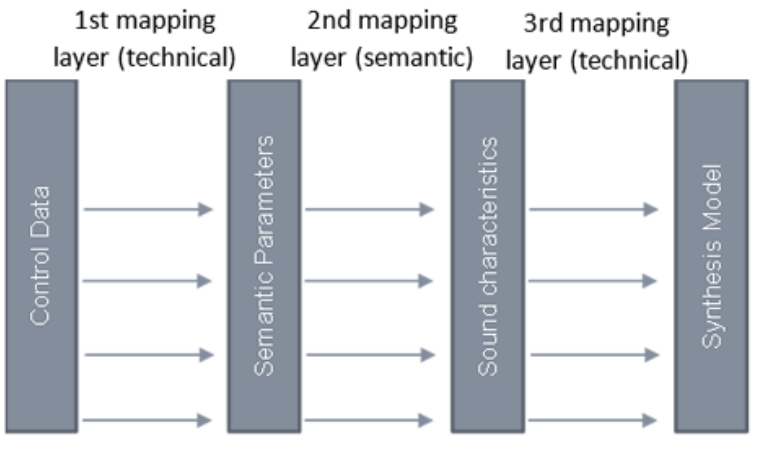
Figure 1. Three-layer mapping. Inspired by